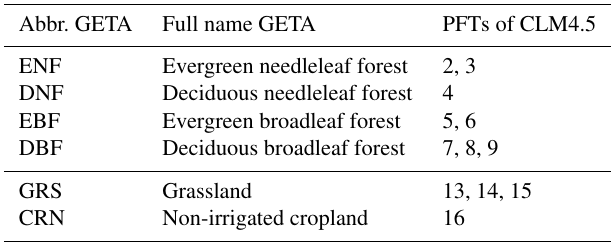
Table A3. The land cover types from Ambrose and Sterling (2014) (GETA) used in this study and the numbers of the respective PFTs in CLM4.5 applied to the different land cover types (Table A2).